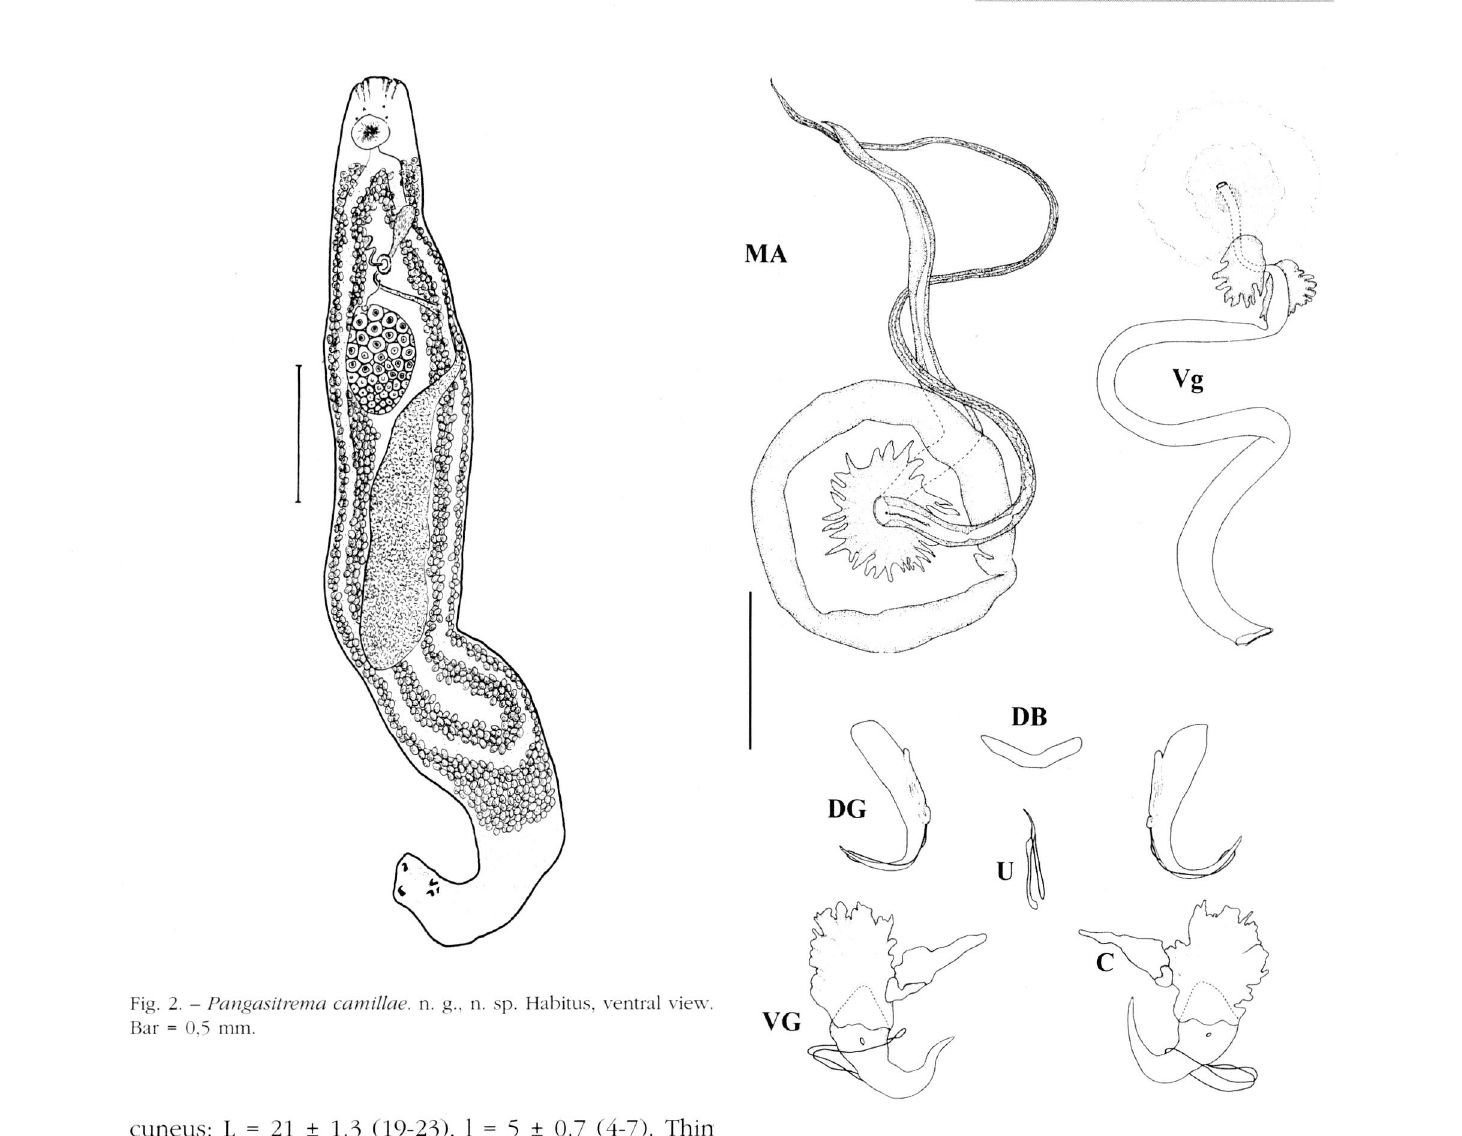
cuneus: L = 21 ± 1.3 (19-23), 1 = 5 ± 0.7 (4-7). Thin uncinuli II = 15 ± 0.9 (14-18). uncinuli I, III-VII = 16 ± Fig. 3- - Pangasitrema camillae n. g.. n. sp.